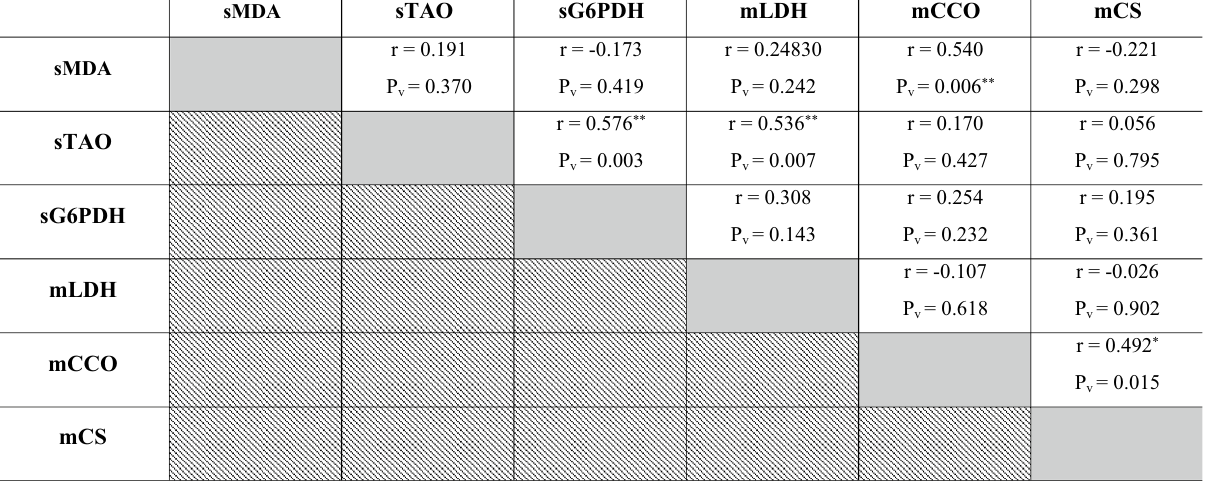
Table 6. Pearson correlation coefficient between serum and muscular oxidant/antioxidant biomarkers in investigated Dabb lizards. sMDA Serum malondialdehyde, sTAO Serum total antioxidant, sG6PDH Serum glucose-6-phospate dehydrogenase, mLDH Muscular lactate dehydrogenase, mCCO Muscular cytochrome c oxidase, mCS Muscular citrate synthase, R Correlation. P v : P value: *Significant (two-tailed) p < 0.05. **Significant (two-tailed) p < 0.01. Gray backgrounds referred to correlation between the same parameter e.g. sMDA and sMDA where there was no correlation. Diagonal backgrounds referred that this correlation